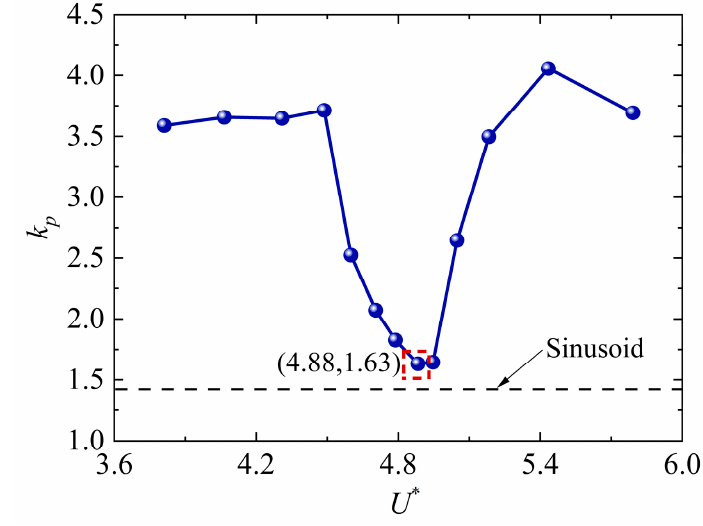
Figure 7. Variation in the peak factor ( k p ) versus reduced velocity ( U* ).